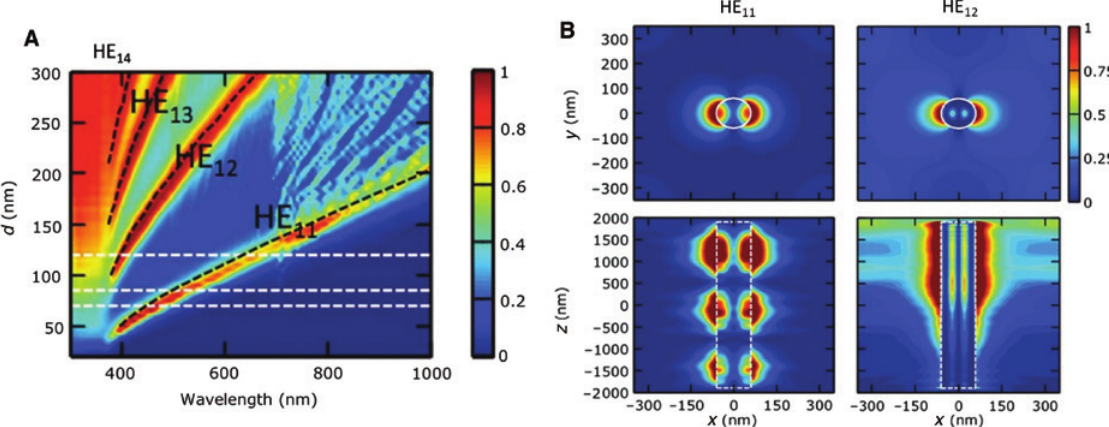
Figure 6: Optical modes of a nanowire. (A) Contour plot of absorption as a function of photon wavelength and nanowire diameter for vertical Si nanowire arrays. (B) Electric field intensity plots of the optical mode of a 120 nm diameter Si nanowires at a wavelength of 670 and 400 nm, which correspond to the HE side) and the HE (right side), respectively. Reprinted with permission from [53]. Copyright (2012) Optical Society of 22